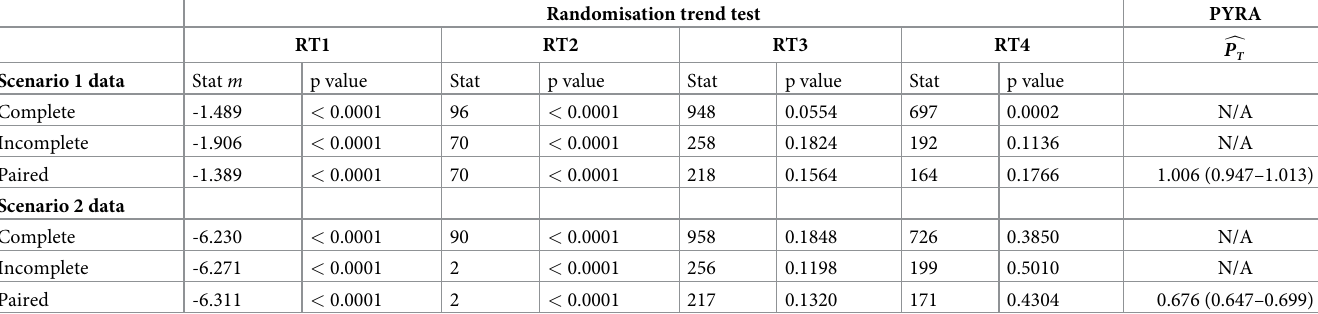
with four randomisation trend tests applied to the synthetic T